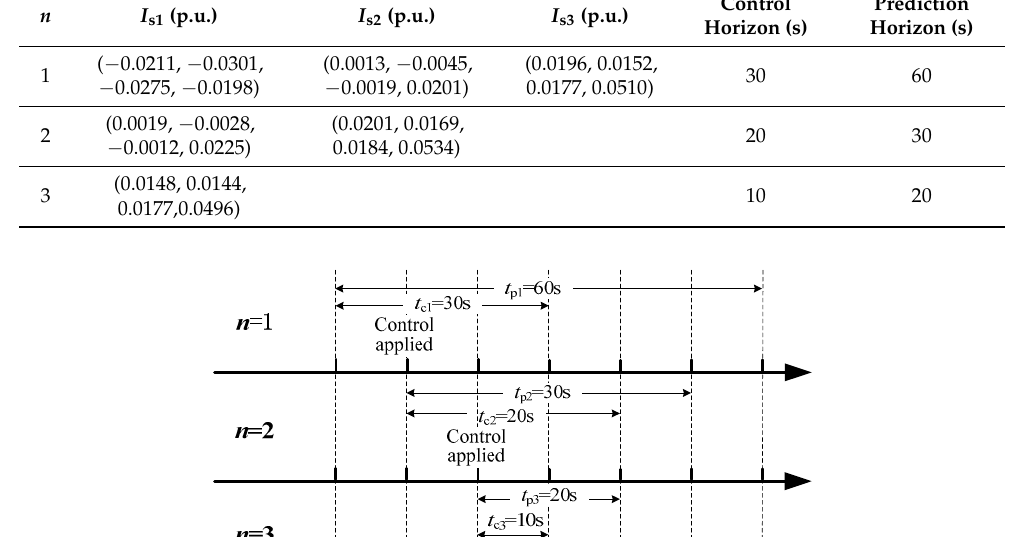
Table 4. The applicability judgment index I s m in case B.